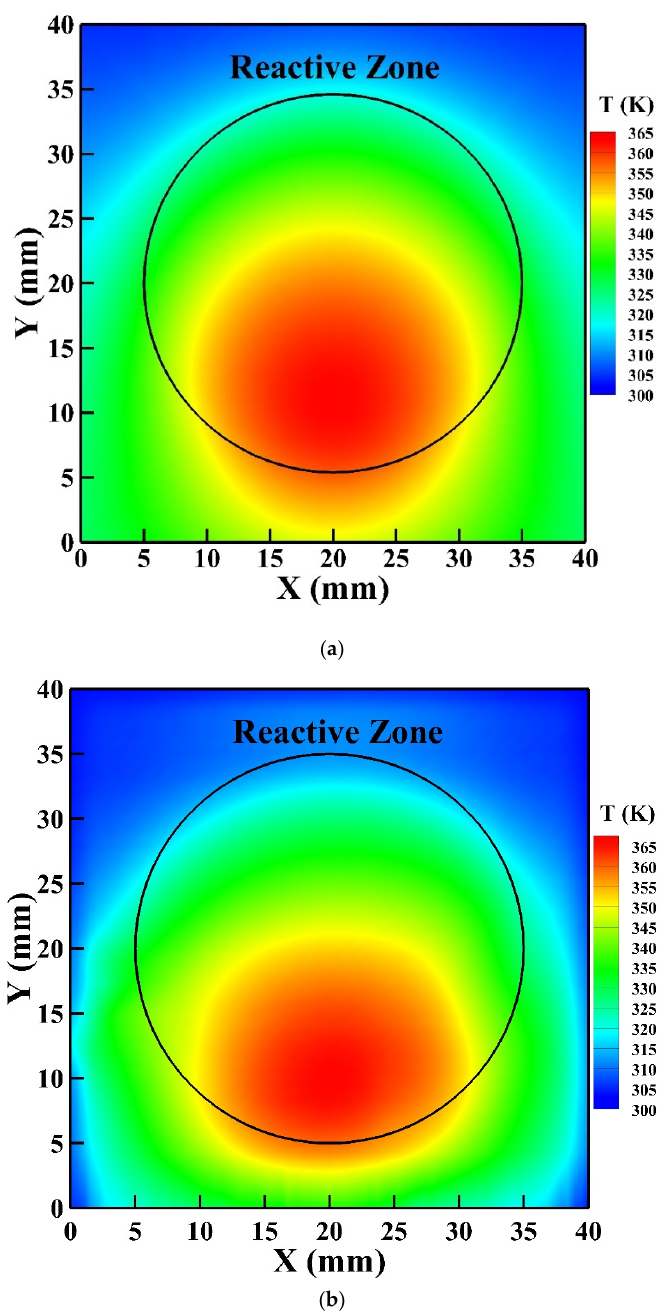
Figure 9. The surface temperature of the reactor: ( a ) simulated by the 3D GFM; ( b ) measured by the infrared (IR) thermal imager.